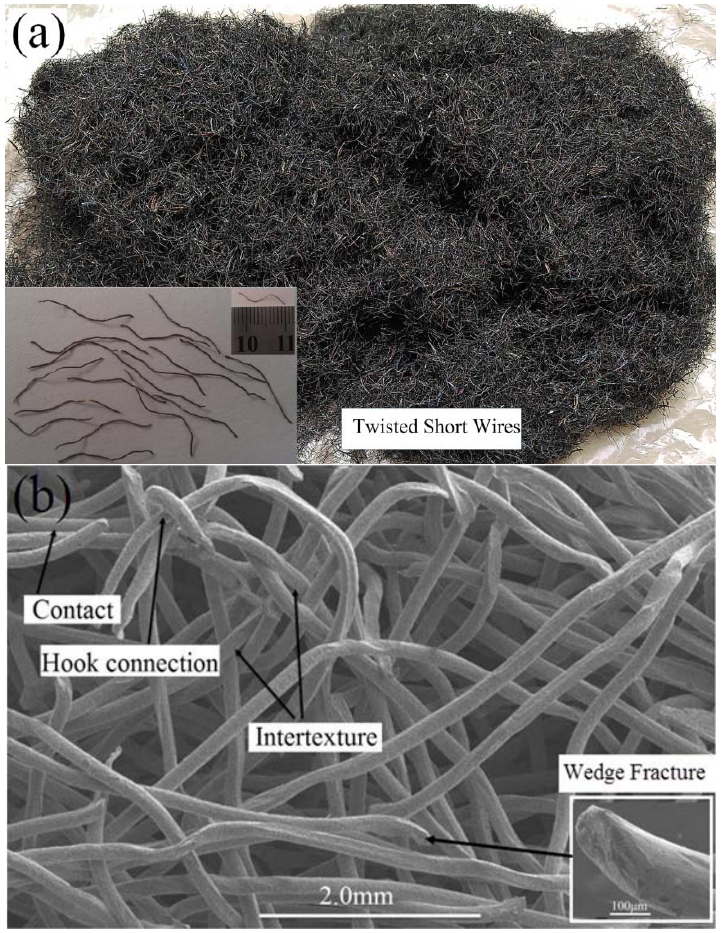
Figure 1. ( a ) Appearance; ( b ) SEM image of twisted short wires fabricated by the self-developed rotary multi-cutter device under natural